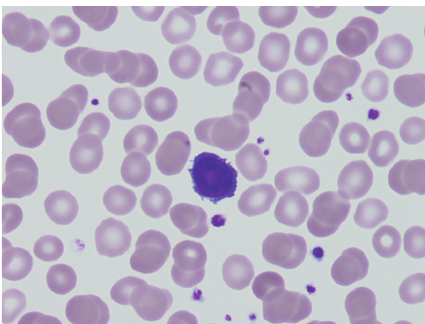
Figure 2: Peripheral blood smear with occasional small lympho- cytes showing ample pale cytoplasm and cytoplasmic projections “hairy